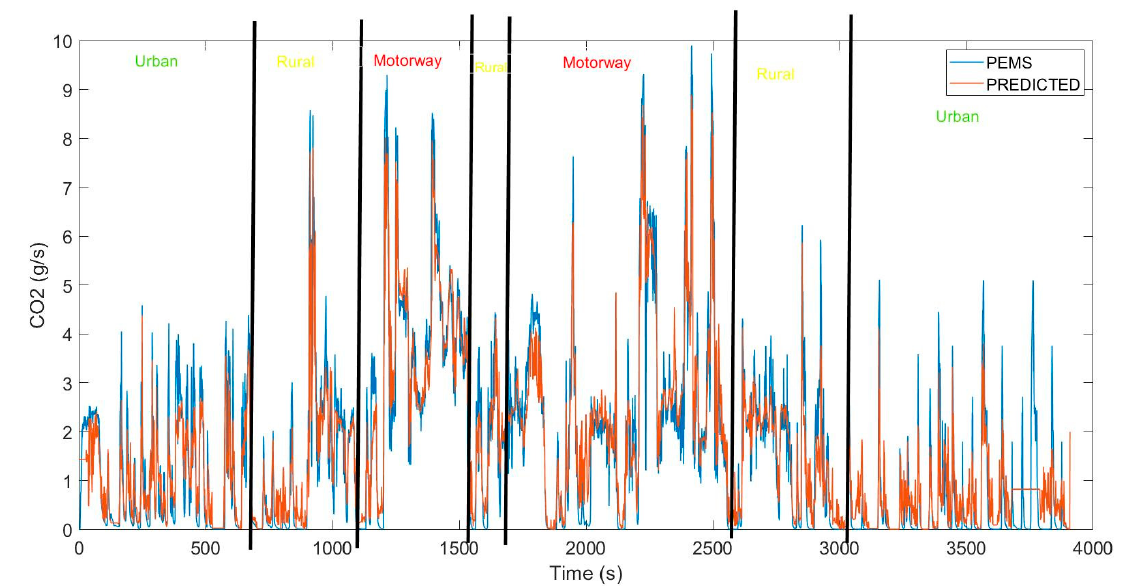
Figure 10. Instantaneous emission of CO 2 for real road data from PEMS and predicted model data.